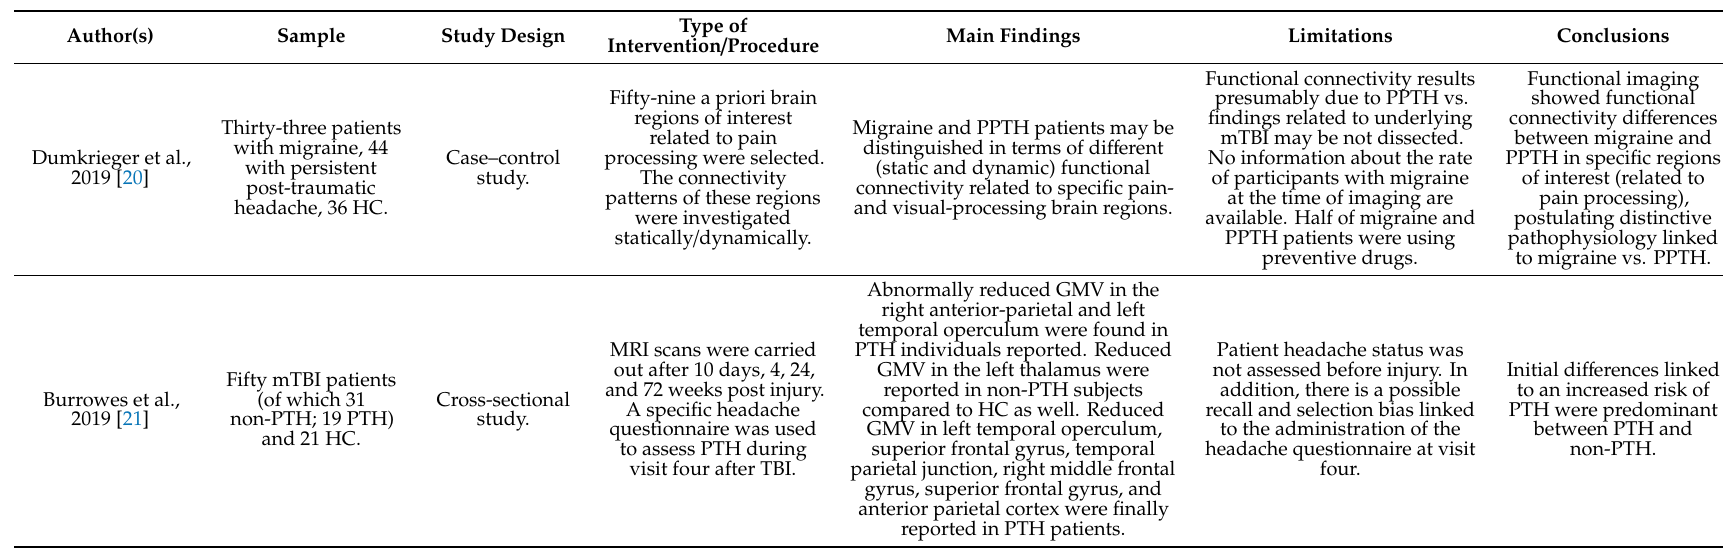
Table 2. Most relevant studies focusing on neurobiological / clinical di ff erential predictors between persistent post-traumatic headache and